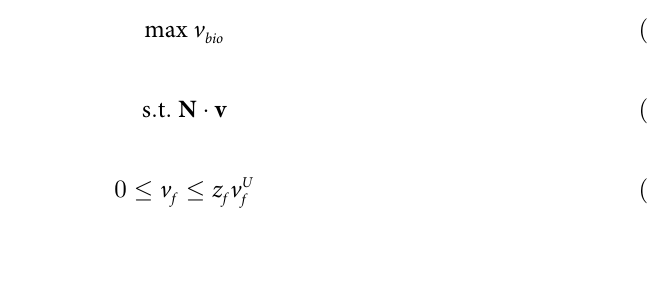
Passive transport, e.g. O 2 and acetate. The factor 10 -6 converts units of mm 3 into L. r met ð ij ; t Þ represents the concentration in a 10 6 V box